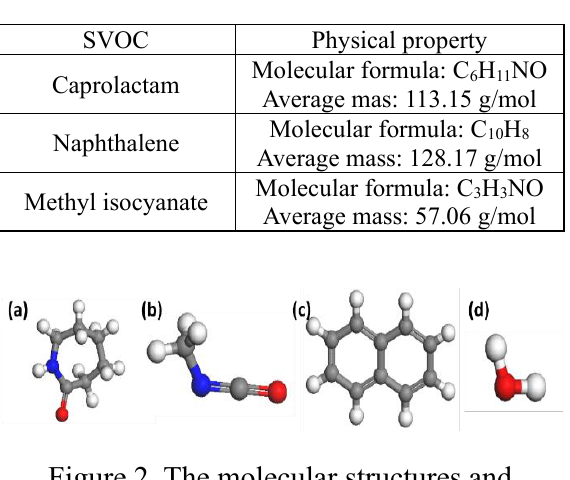
Table 1. Physical properties of selected SVOCs [18]